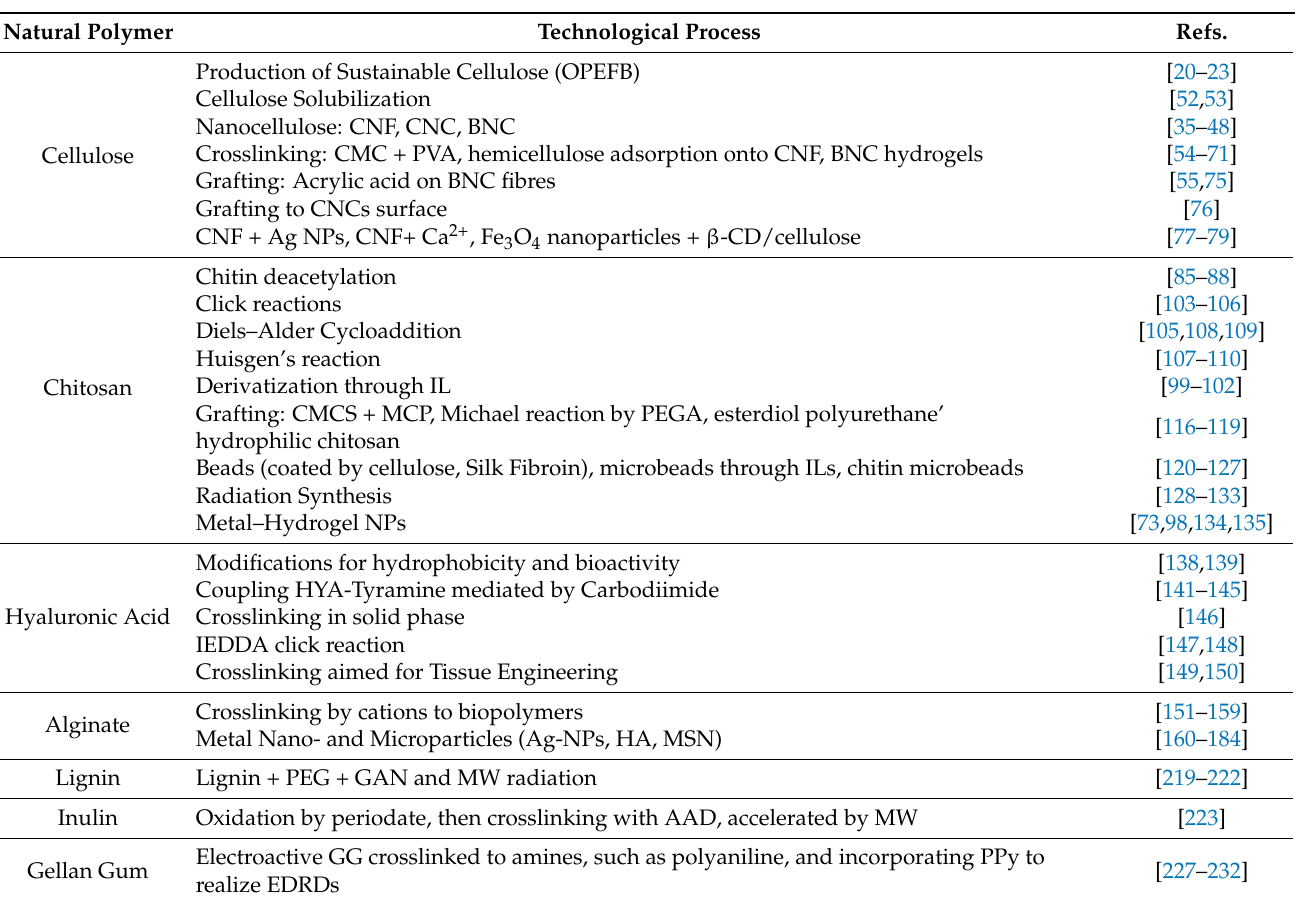
Table 1. Grouping of hydrogels based on the biopolymeric main component, and the technological process followed for their preparation. Acronyms used inside the table are described in the text. Natural Polymer Technological Process